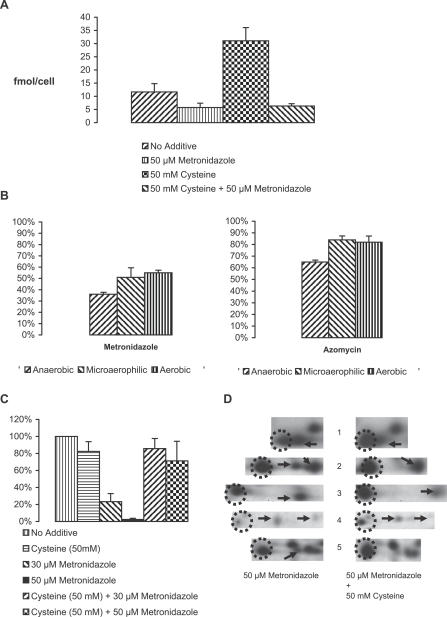
Interdependence of Non-Protein Thiols and Metronidazole Toxicity(A) Metronidazole diminishes non-protein thiol levels in the cell. Determination of total non-protein sulfhydryl groups (fmol/cell), i.e., free thiols, in the cell after treatment of E. histolytica cells for 2 h with either additional 50 mM cysteine (67 mM in total) or 50 μM metronidazole alone, or both in combination. The experiment was independently performed three times. Vertical bars indicate standard deviations.(B) The decrease of non-protein thiols is most pronounced under anaerobic conditions when treating cells with metronidazole and azomycin. Cells were either treated with 50 μM of metronidazole (left) or azomycin (right) for 2 h under anaerobic (0% O2 and 18% CO2), microaerophilic (5% O2 and 8% CO2), and aerobic (21% O2 and 0.4% CO2) conditions. Values are given as percentages of non-protein thiol concentrations of the respective untreated samples.(C) Cysteine counteracts metronidazole toxicity. E. histolytica cells were treated with either 30 μM or 50 μM of metronidazole in the presence or absence of additional 50 mM cysteine for 20 h. Viability of cells was determined by trypan blue exclusion. The experiment was independently repeated three times. Numbers of viable cells are given as percentages of total cell counts. Vertical bars indicate standard deviations.(D) Cysteine reduces adduct formation of proteins with metronidazole. Cells were treated with 50 μM of metronidazole either in the presence or absence of additional 50 mM cysteine for 2 h. Afterwards, cell lysates were prepared, and the extent of adduct formation of superoxide dismutase (1), thioredoxin reductase (2), thioredoxin (3), metronidazole target protein 1 (4), and purine nucleoside phosphorylase (5) with metronidazole was visualized by 2DE. Unmodified proteins are encircled, and shifted proteins are indicated by arrows.